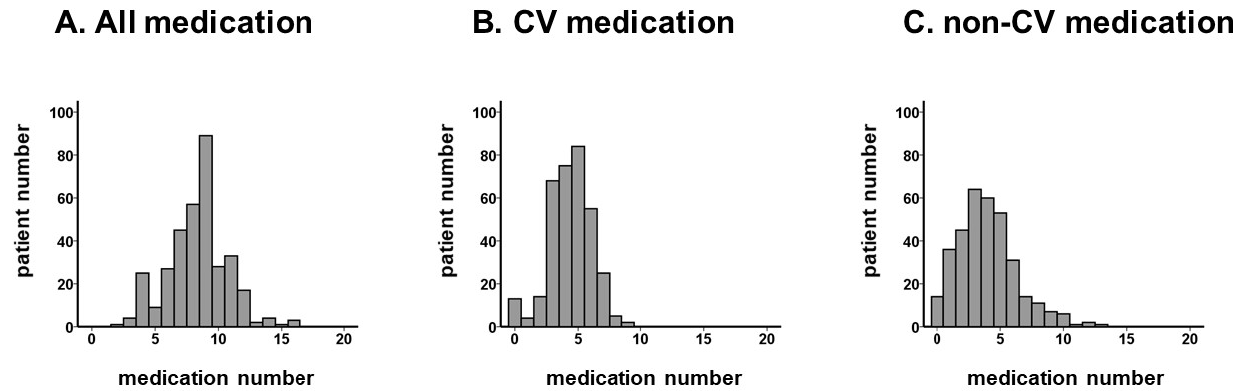
Figure 1. Distribution of medication numbers: all medication ( A ), CV medication ( B ), and non-CV medication ( C ). The number of medications was distributed widely. The distribution of CV medication is relatively narrower than for non-CV medication.CV, cardiovascular.